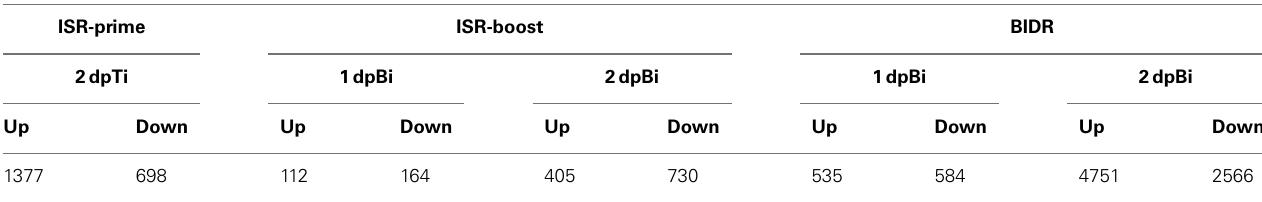
Table 1 | Numbers of differentially expressed (DE)